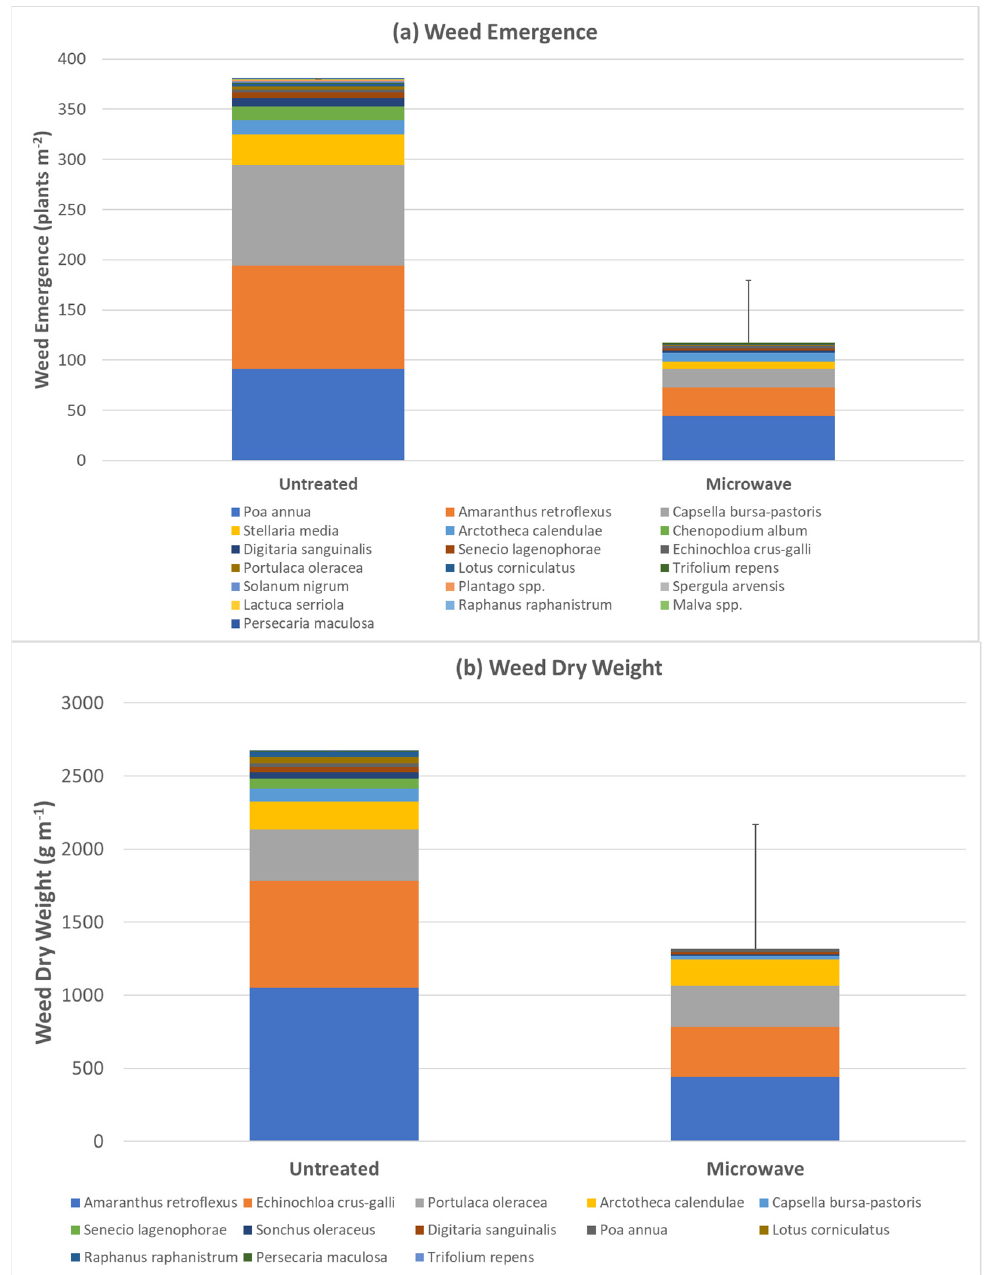
Figure 5. Weed ( a ) emergence and ( b ) total dry weight in soils treated with microwave or an untreated control in field Experiment 2 (19/20) in the strawberry runner sector. The bars are the LSDs where p = 0.05.